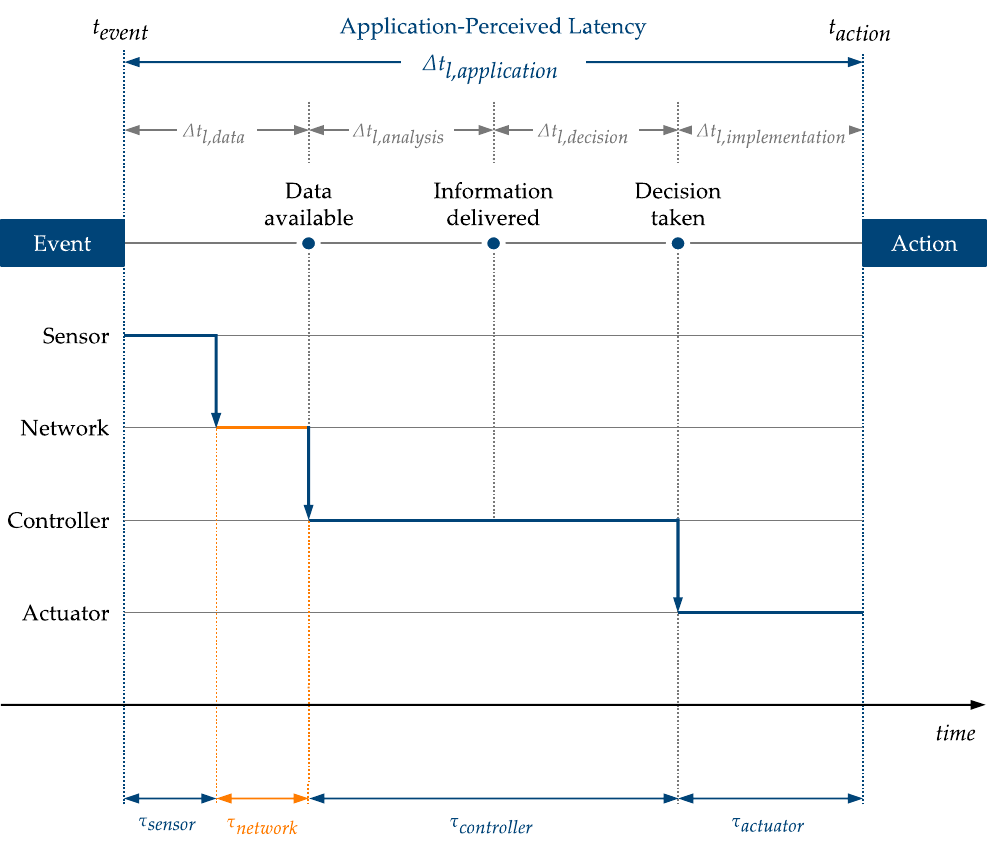
Figure 3. Latencies in a networked control system.